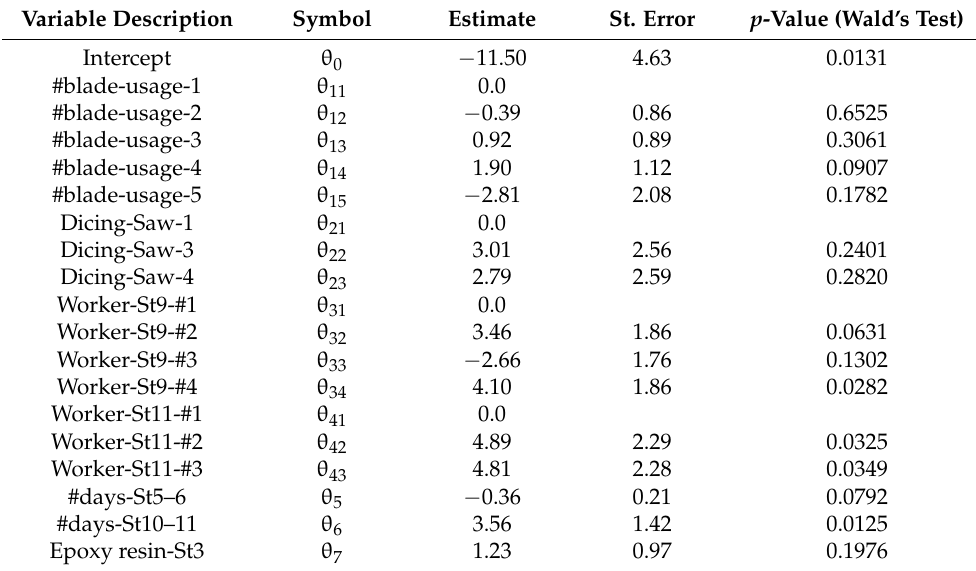
Table 2. Logit model results. Response Y = binary response variable; Formulas (4) and (6). Variable